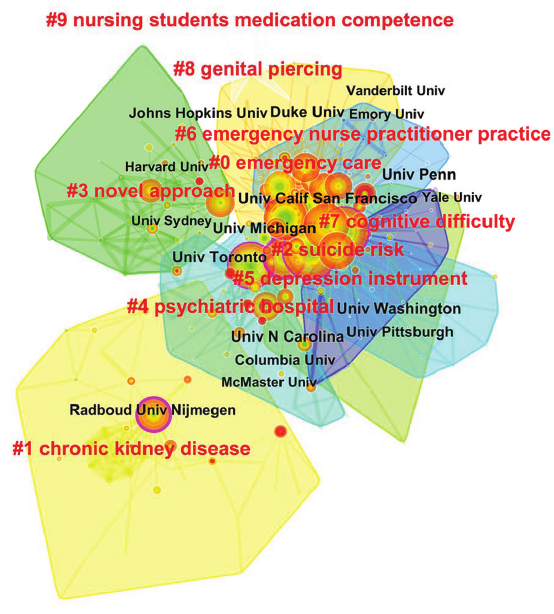
Figure 2. Knowledge map of institution related to Nurse Practitioners (2007-2018).